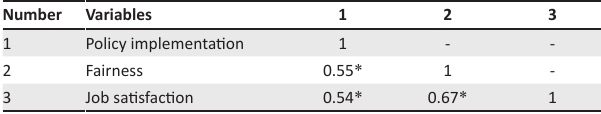
FIGURE 1: Employee perception of performance management and job satisfaction at a subdimension